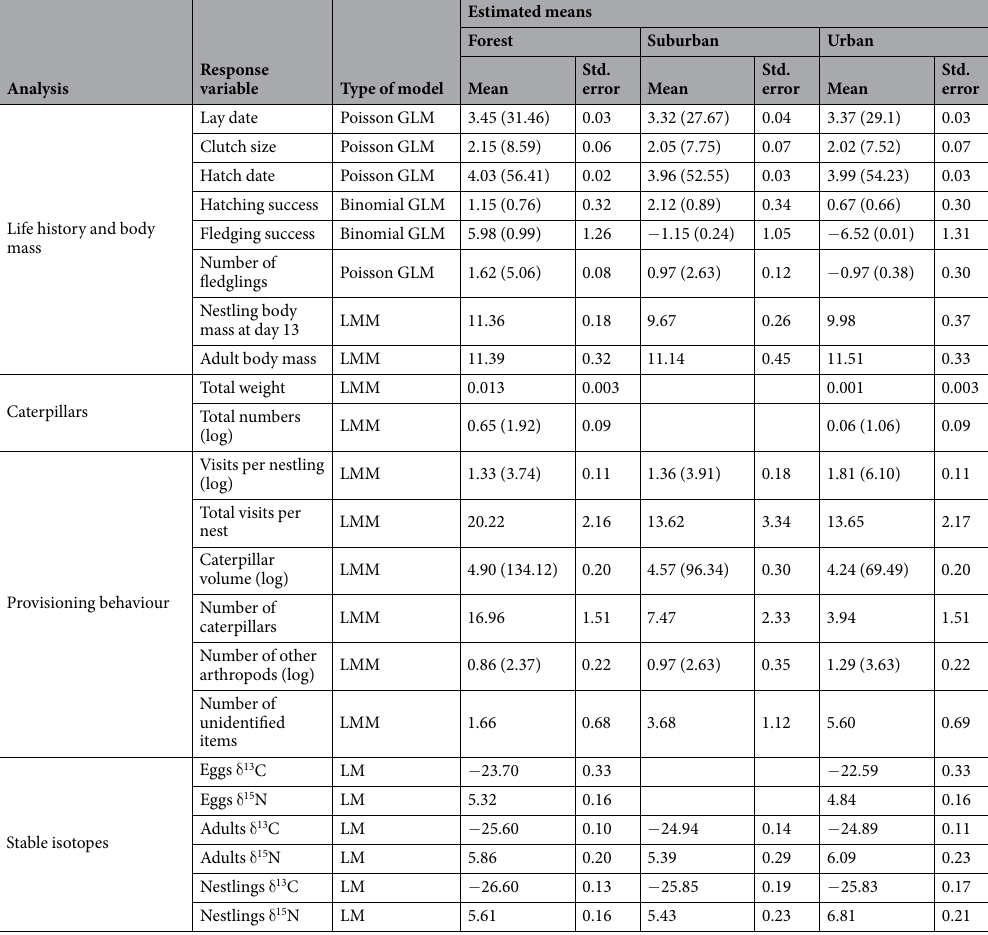
Table 2. Estimated least square means obtained from model predictions (full models given in Tables 3, 4, 5 and 6). For GLMs as well as LMMs in which the response variable was log-transformed, we give both the estimated mean and in brackets the back-transformed mean. The standard errors of those means are not back-